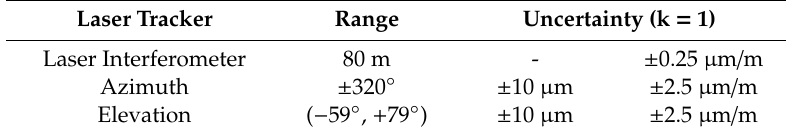
Table 3. Laser tracker model parameters with uncertainty values obtained from data